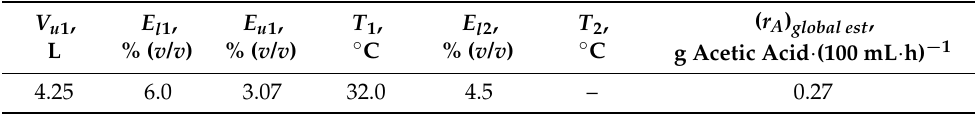
Table 2. Values of the operational variables needed to maximize ( r A ) global est